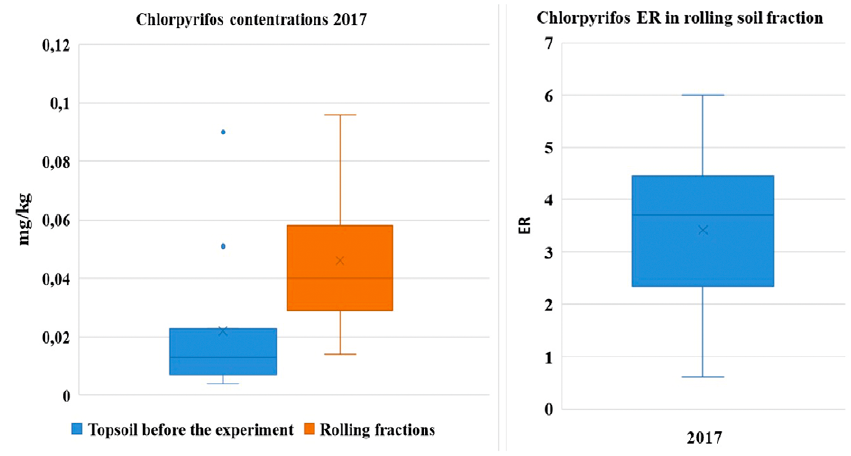
Figure 8. Results of concentration and enrichment ratio (ER) of chlorpyrifos in 2017